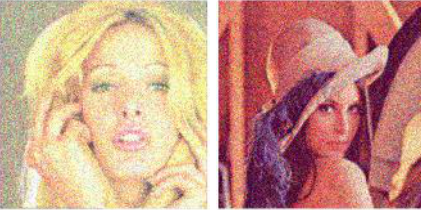
Figure 4. Blurred and noisy Barbara and Lenna test images.